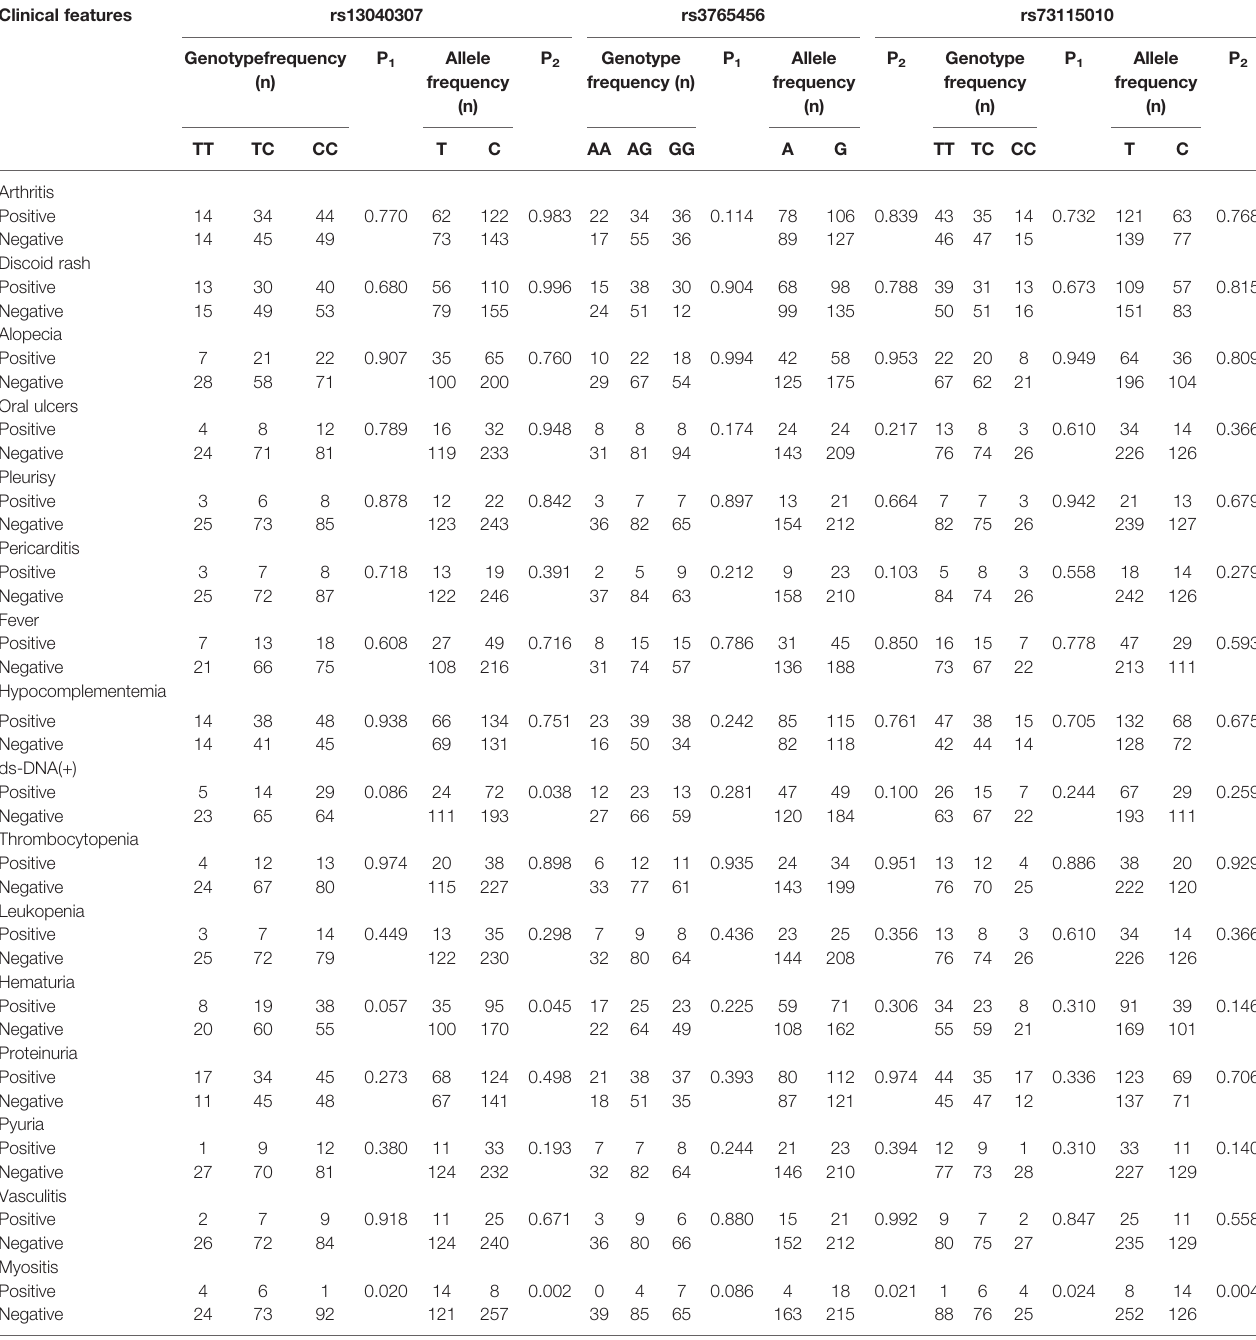
P 1 , Patients positive versus patients negative using 3×2 contingency table. P 2 , Patients positive versus patients negative using 2×2 contingency